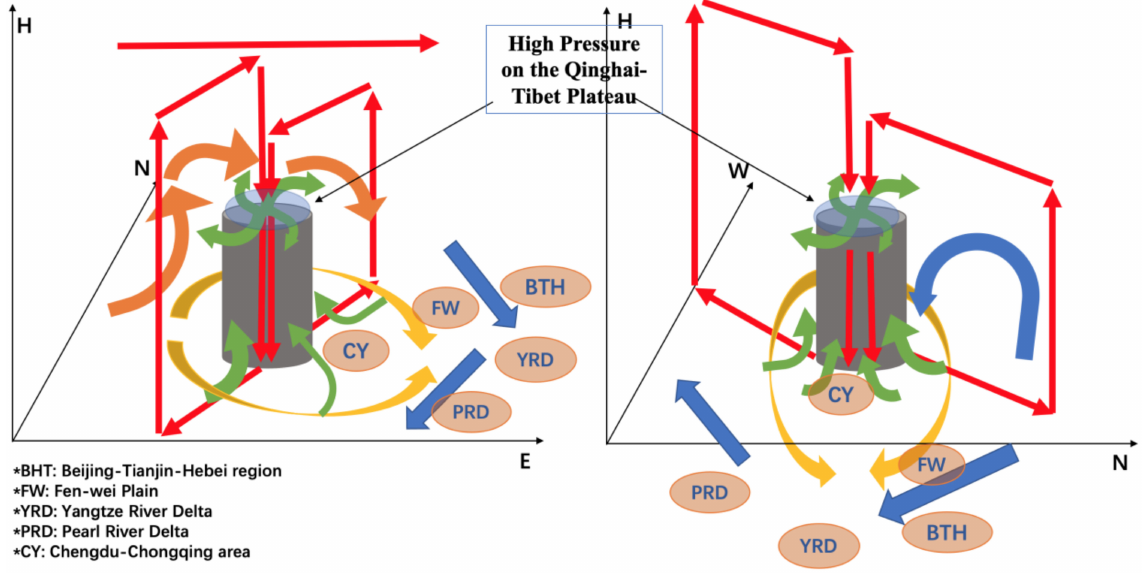
Figure 1. Overview of atmospheric circulation over and around the Tibetan